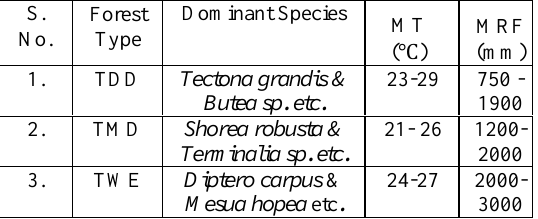
Table 1. Type of selected forest and their specific characters